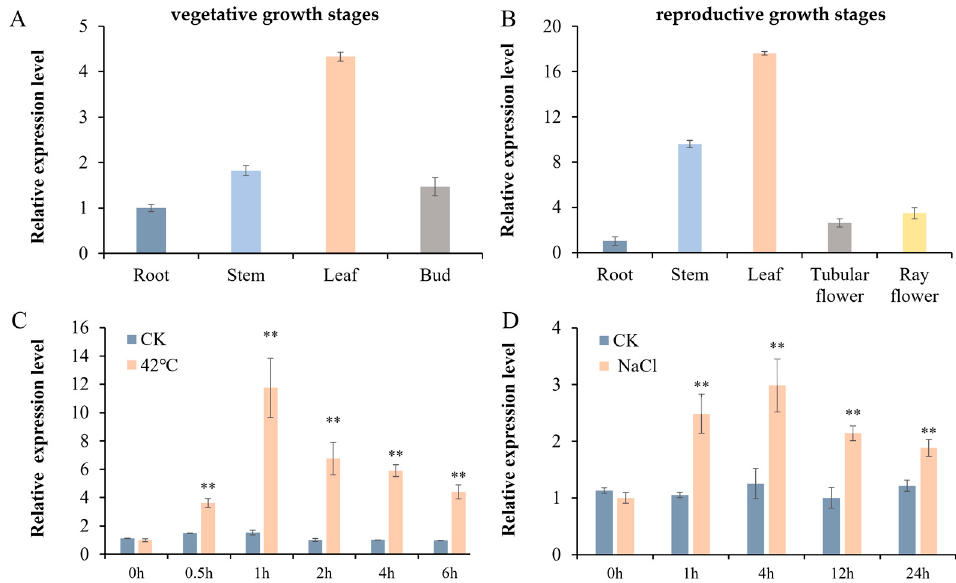
Figure 3. Expression profiling of CmHSP90.5 in Chrysanthemum ‘ Jinba ’. ( A ) Transcript abundances of CmHSP90.5 in different tissues at vegetative growth stages. ( B ) Transcript abundances of CmHSP90.5 in different tissues at reproductive growth stages. CmHSP90.5 expression was induced by heat stress ( C ) and NaCl treatment ( D ). Error bars represent ± SE. ** Statistically significant differences were compared with Col-0 plants under different conditions. Value of p < 0.01 was considered to be statistically significant.